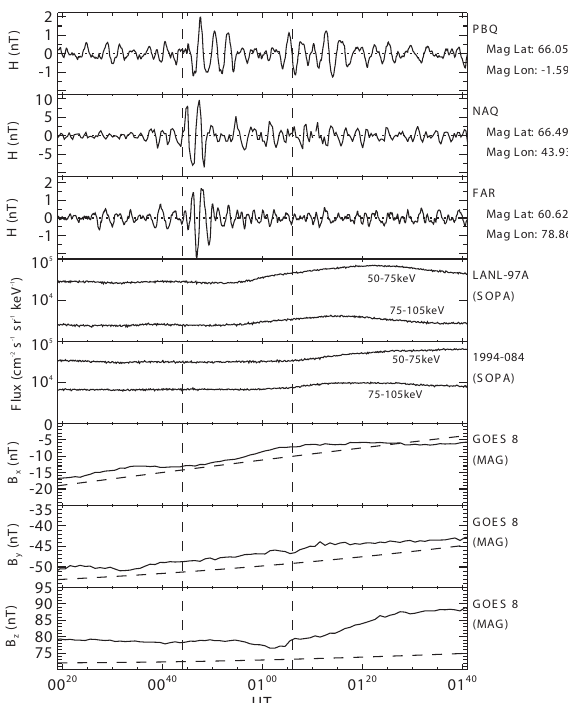
Fig. 5. SuperDARN line-of-sight velocity measurements from the radar beams indicated in Fig. 1a are shown for the interval 00:20– 01:40UT on 2 December 1999. In the top panel the H -component magnetic field measured by the GHB magnetometer is also shown for purposes of comparison. The vertical dashed lines are as in Fig.